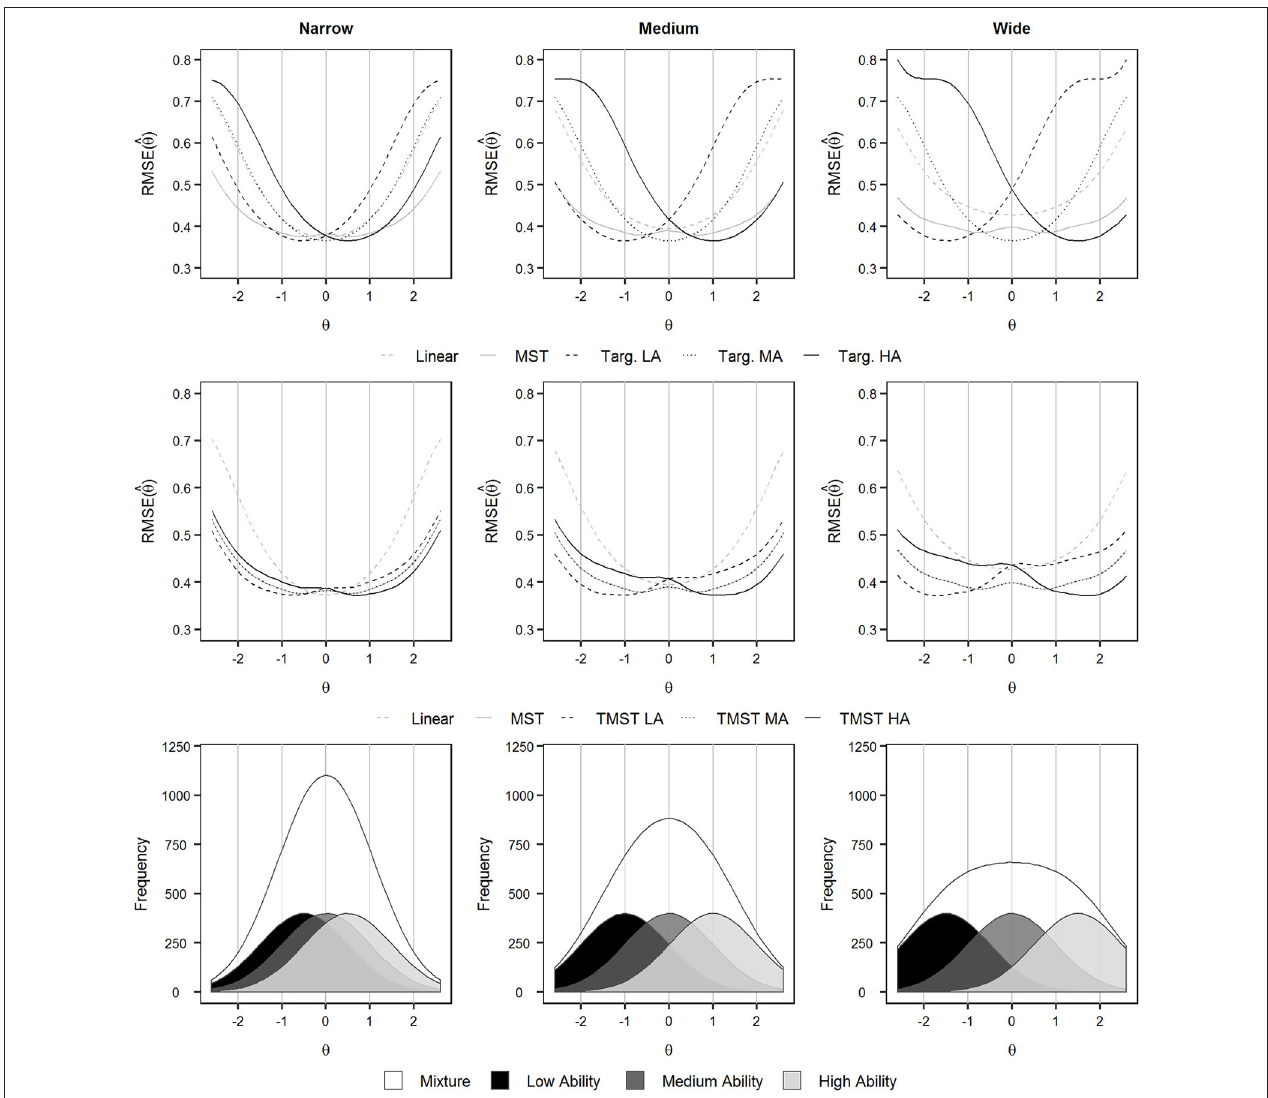
FIGURE 3 | RMSE( ˆ θ ) in relation to ability per ability group for the different designs under the three distribution conditions, and related frequency distributions of the ability groups. Targ., targeted test design; LA, low-ability group; MA, medium-ability group; HA, high-ability